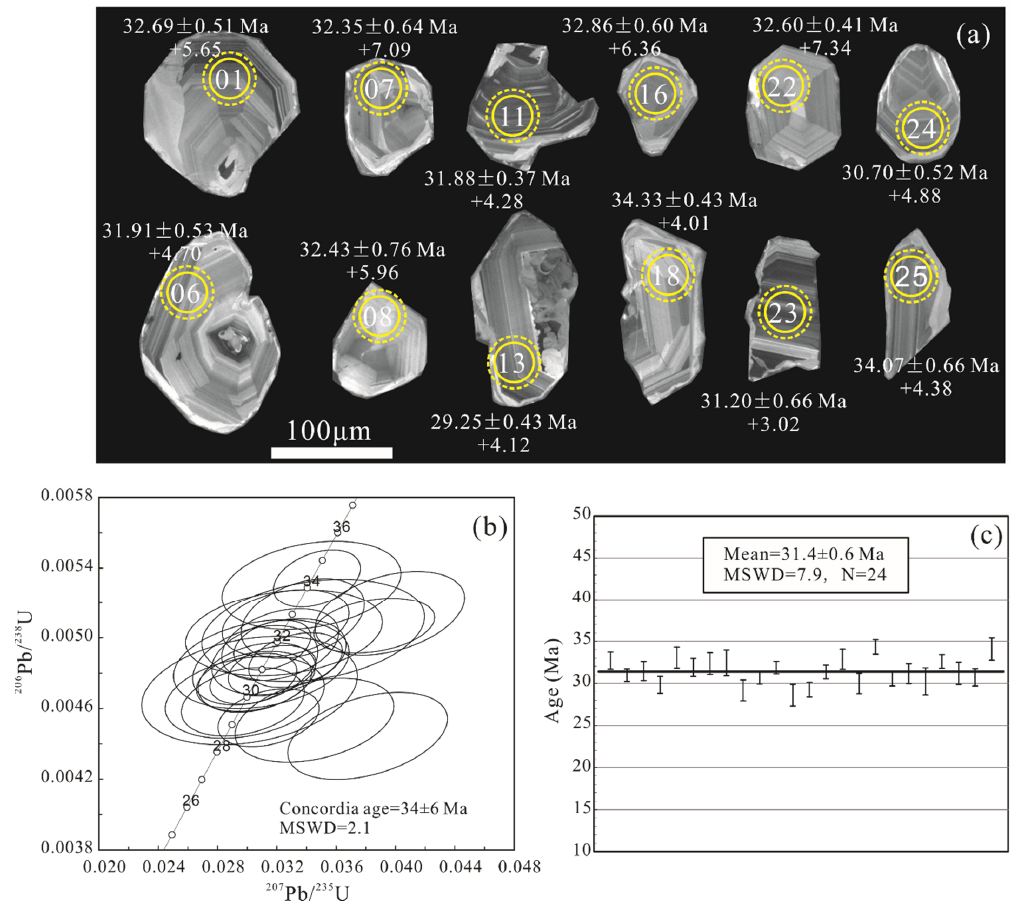
Figure 3. Representative CL images of zircons and concordia diagrams ( a ) and LA-ICP-MS U–Pb zircon Concordia diagrams and weighted ages of the Mingze monzodiorites ( b , c ).